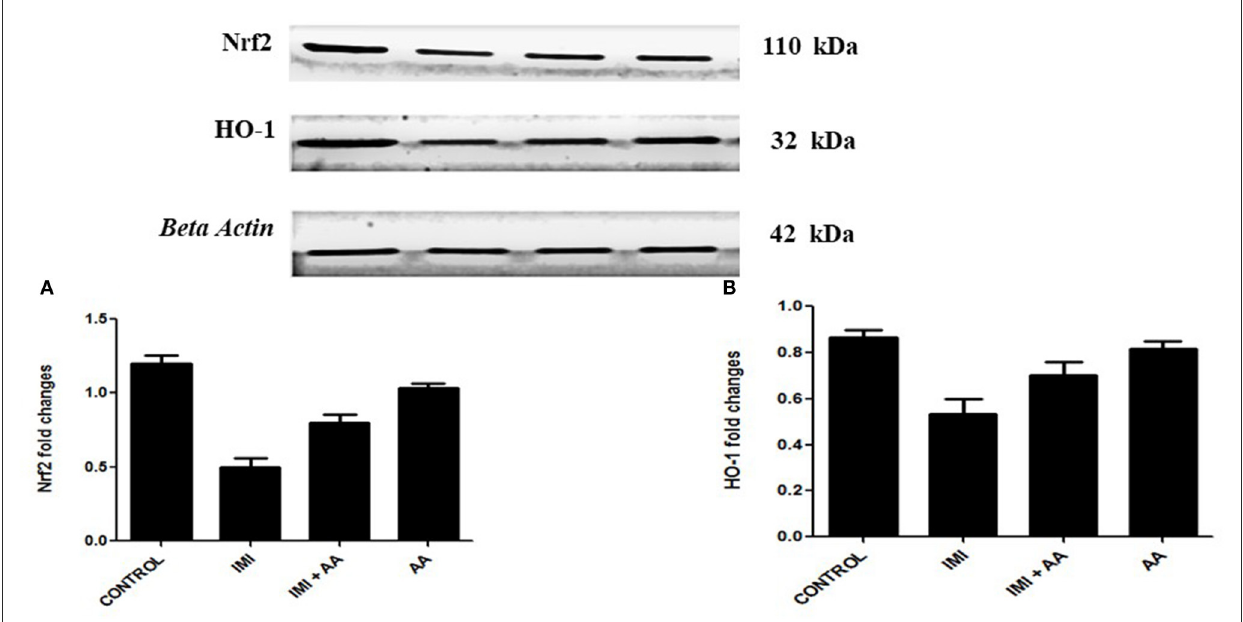
FIGURE6 Western blot analysis for Nrf2, heme oxygenase-1 (A) Western blots for the measured factors in comparison to β -actin, lane 1 (control), lane 2 (IMI treated), lanes 3 (Ascorbic acid + IMI (200 mg/kg), and lane 4 (Ascorbic acid (200 mg/kg). Column charts for fold changes in Nrf2. (A) , heme oxygenase-1 (B) . IMI, Imidacloprid; AA, Ascorbic acid; HO-1, heme oxygenase-1 Data are the mean ± SD, and analysis was done by one-way ANOVA followed by Tukey’s post-hoc test. (a) P -value < 0.05 compared to the control group, (b) P -value < 0.05 compared to the IMI group, and (c) P -value < 0.05 compared to the AA (200 mg/kg)